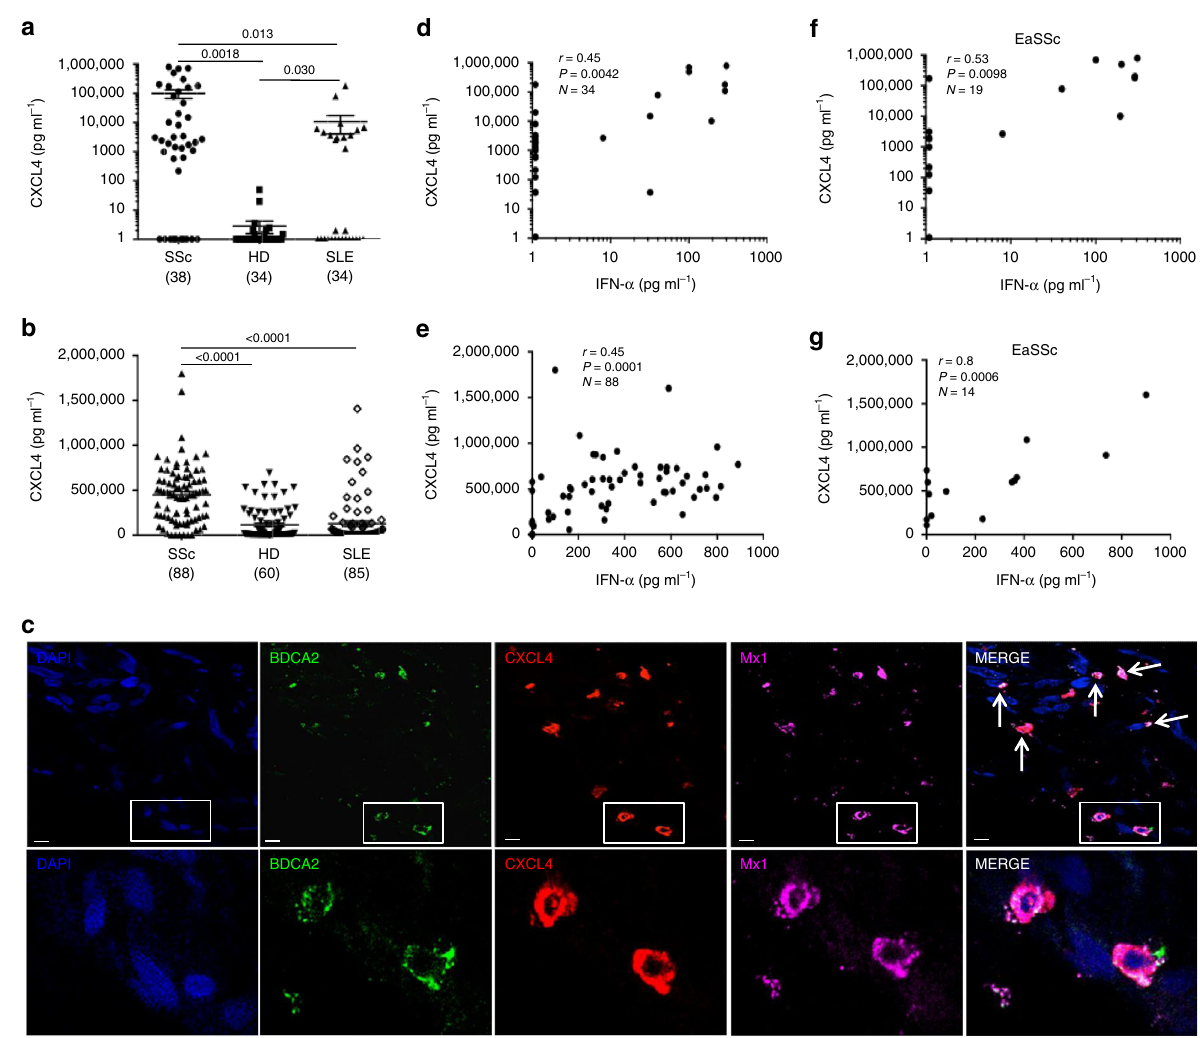
Fig. 1 CXCL4 is overexpressed in SSc and correlates with IFN-I. CXCL4 was measured by ELISA in the plasma of SSc ( N = 38) (discovery cohort), HD ( N = 34), and SLE ( N = 34) ( a ), and in the sera of SSc patients ( N = 88), HD ( N = 60), and SLE patients ( N = 85) ( b ). Horizontal bars are the means and vertical bars are the standard errors of the mean (s.e.m.). P -values are calculated with Student ’ s t test for unpaired samples (two-tailed). c Confocal images of SSc skin stained with DAPI (blue) to color nuclei, anti-BDCA2 (green), anti-Mx1 (magenta), and anti-CXCL4 (red). White arrows indicate co-localization of BDCA2, CXCL4, and Mx1. Upper images show a dermal compartment (objective ×60; bar, 10 µ m). Lower images show a detail (inset) of the dermal compartment. One representative experiment of 10 performed with different SSc donors. Amounts of CXCL4 measured in SSc plasma ( d , f ) or serum ( e , g ) were correlated to IFN- α level measured by ELISA in the same sera/plasma. Correlation was measured by Pearson ’ s correlations test. Coef fi cient of correlation “ r ” , signi fi cance “ P ” , and sample size “ N ” are